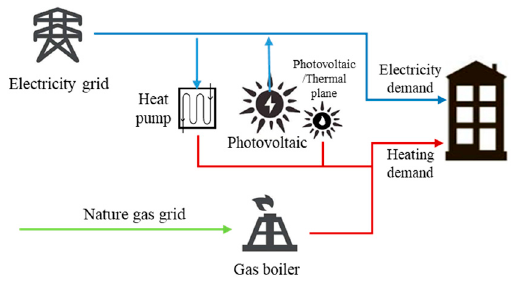
Figure 4. Single Building energy hub